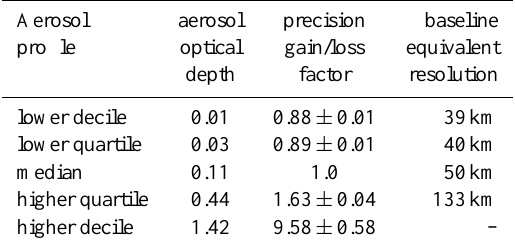
Table 5. Impact of beam attenuation by a thin cirrus cloud layer in Table 4. Influence of beam attenuation by aerosol on methane col- 9km altitude on methane column precision. The indicated equiva- umn precision. In an atmosphere with less (more) aerosol load than lent resolution would be needed to re-establish a measurement pre- the median, the performance is improved (degraded) by the indi- cision of 0.8%, valid for the cloud-free baseline. cated factor. The indicated equivalent resolution would be needed to re-establish a measurement precision of 0.8%, valid for the me- dian aerosol baseline. cirrus Aerosol aerosol precision baseline profile optical gain/loss equivalent depth factor resolution lower decile 0.01 0.88 ± 0.01 39km lower quartile 0.03 0.89 ± 0.01